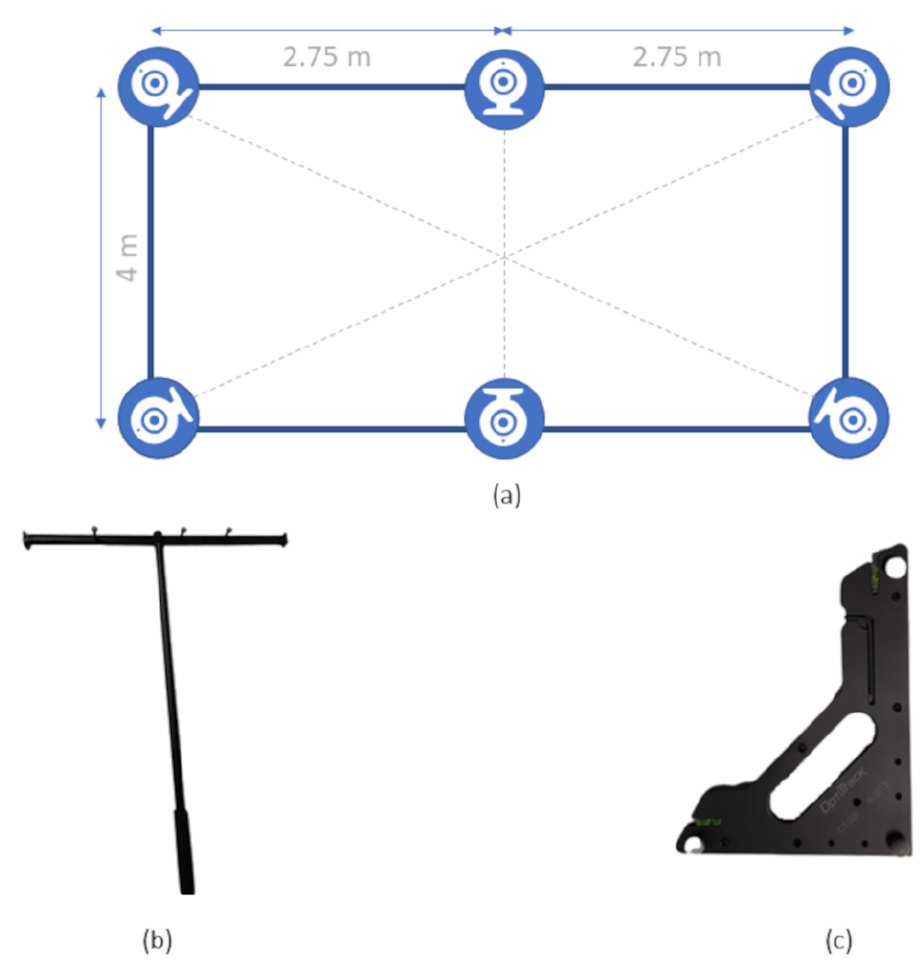
Figure 2. OptiTrack system: ( a ) OptiTrack setup. ( b ) Calibration tool. ( c ) Ground plane tool. OptiTrack markers are small reflective spheres with a 14 mm diameter (observable